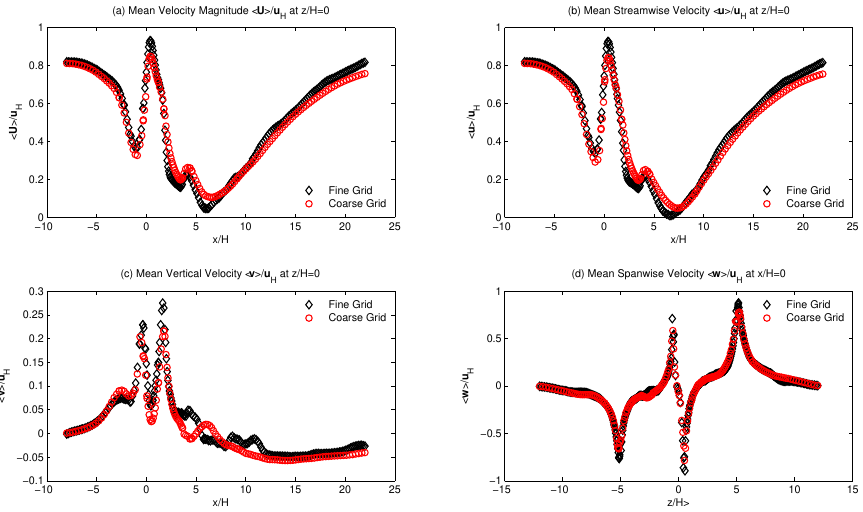
Figure 8. Grid independence test: velocity distributions for y / H =